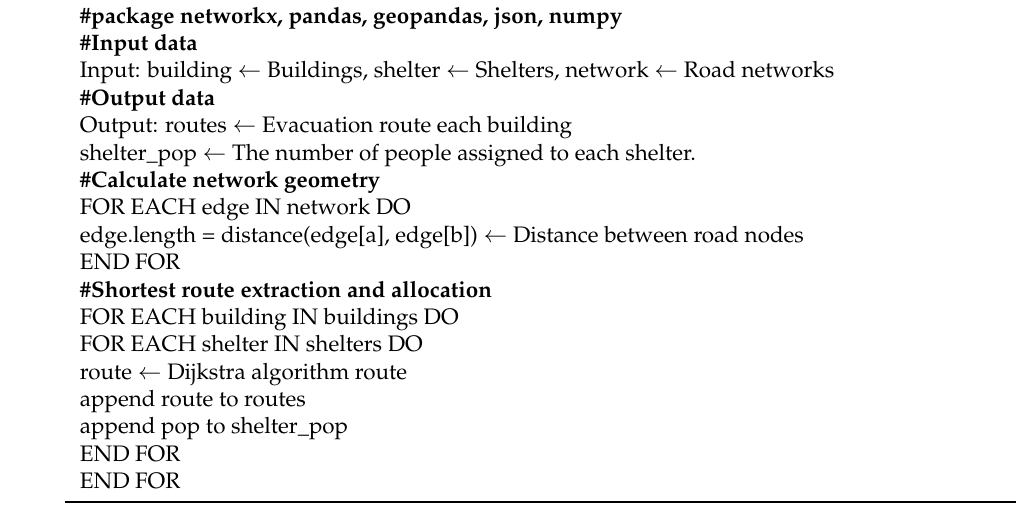
Table 2. Pseudocode for the derivation of evacuation routes.